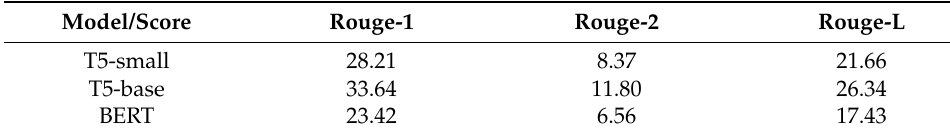
Table 3. Performance evaluation (output length: 100).